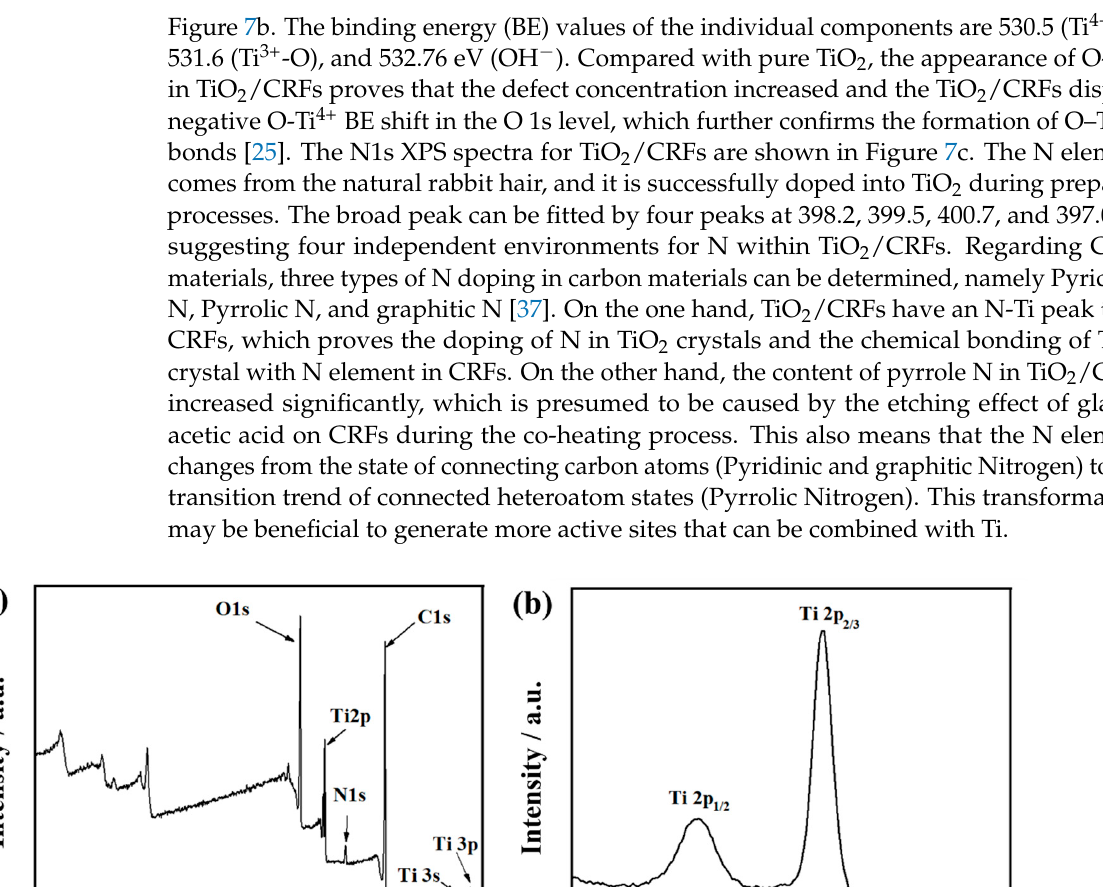
Figure 7b. The binding energy (BE) values of the individual components are 530.5 (Ti 4+ -O), 531.6 (Ti 3+ -O), and 532.76 eV (OH − ). Compared with pure TiO 2 , the appearance of O-Ti 3+